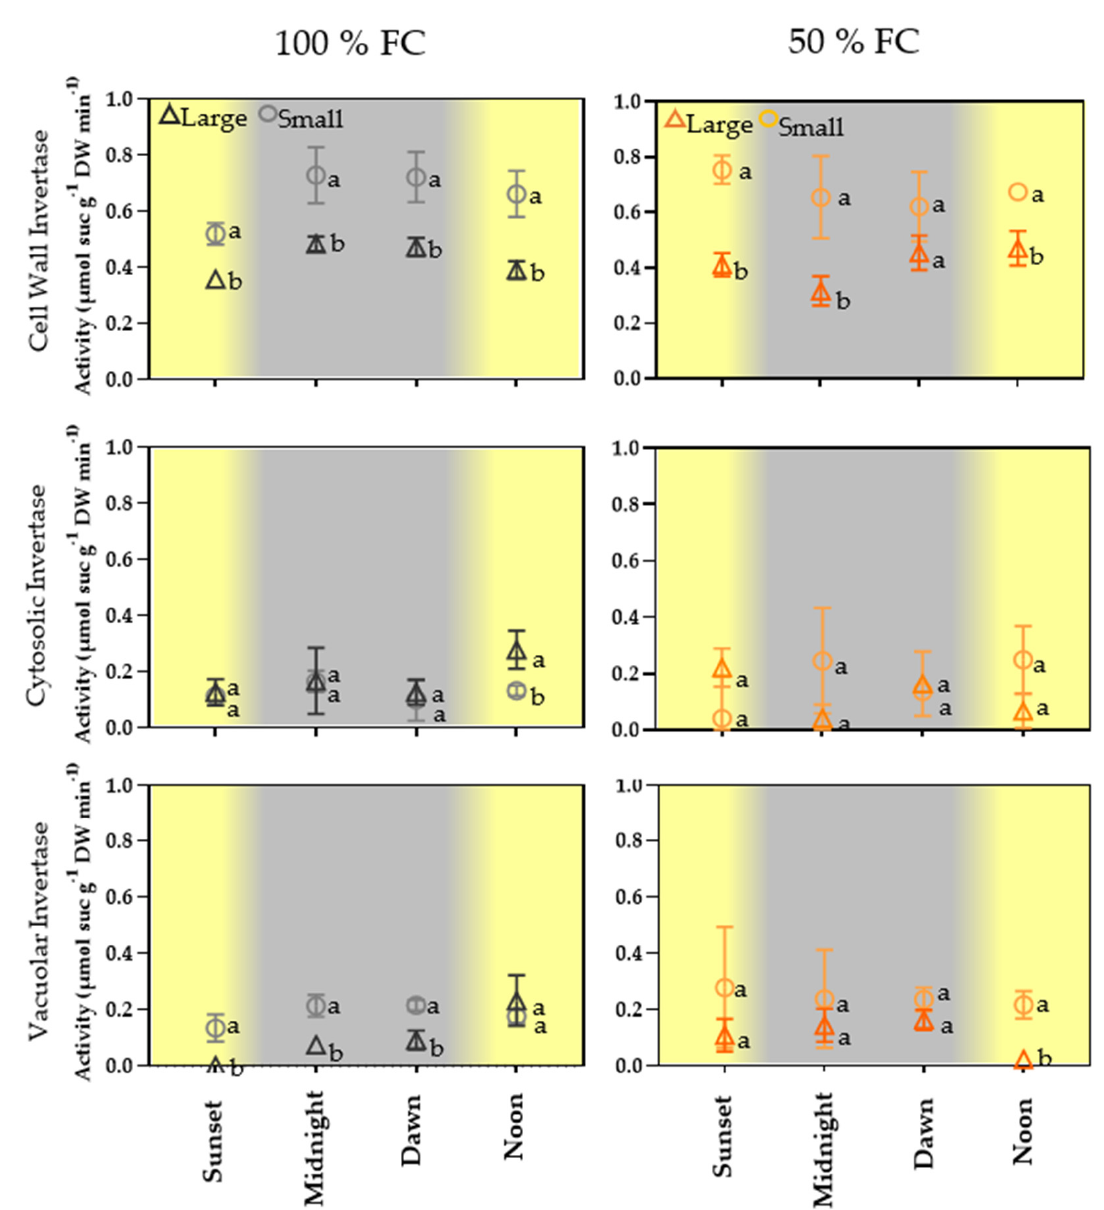
Figure 4. Activities ± SE of cell wall invertase, cytosolic invertase, and vacuole invertase in pericarp from pod sets (large and small) at 100% FC and over 10 d at 50% FC. The pod sets were sampled at sunset (6:00 p.m.), midnight (12:00 a.m.), dawn (6:00 a.m.), and noon (12:00 p.m.); n = 4. The same letters on the boxes indicate similarity between treatments (Student’s t test, p < 0.05).